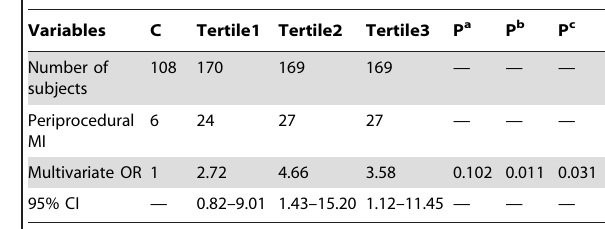
To explore the relationship between stented coronary calcifica- tion and PMI, logistic regression analysis was also performed. Table 4 ) and HP group (OR 3.43, 95% CI 1.98–5.95, p , 0.001),